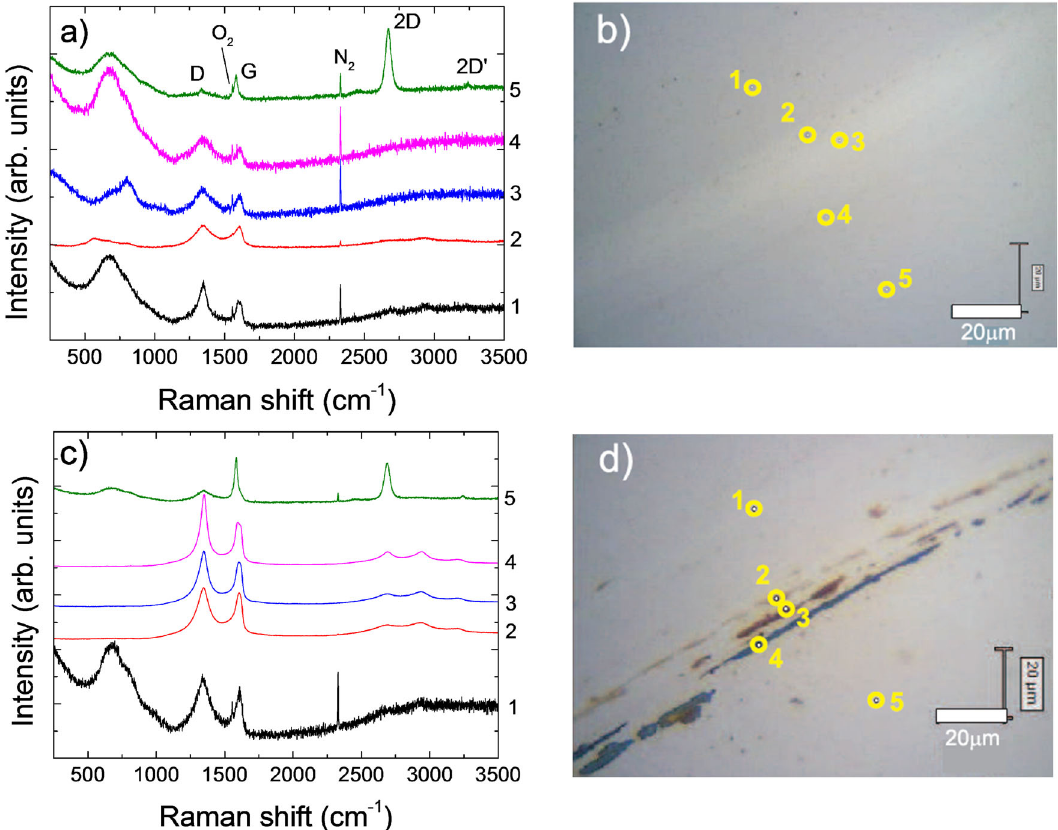
Fig. 5 Raman measurements across wear tracks. Raman spectra, normalized to I (G), recorded across wear tracks of ( a ) 1LG and ( c ) 2LG and corresponding optical pictures in ( b ) and ( d ). In ( b ), ( d ) The Raman spectra are recorded across the wear tracks at the positions indicated by the yellow circles to compare graphene before and after friction and wear tests. The colors of the traces are due to a mixture of graphene, HDM components, and polymer residues coming from graphene